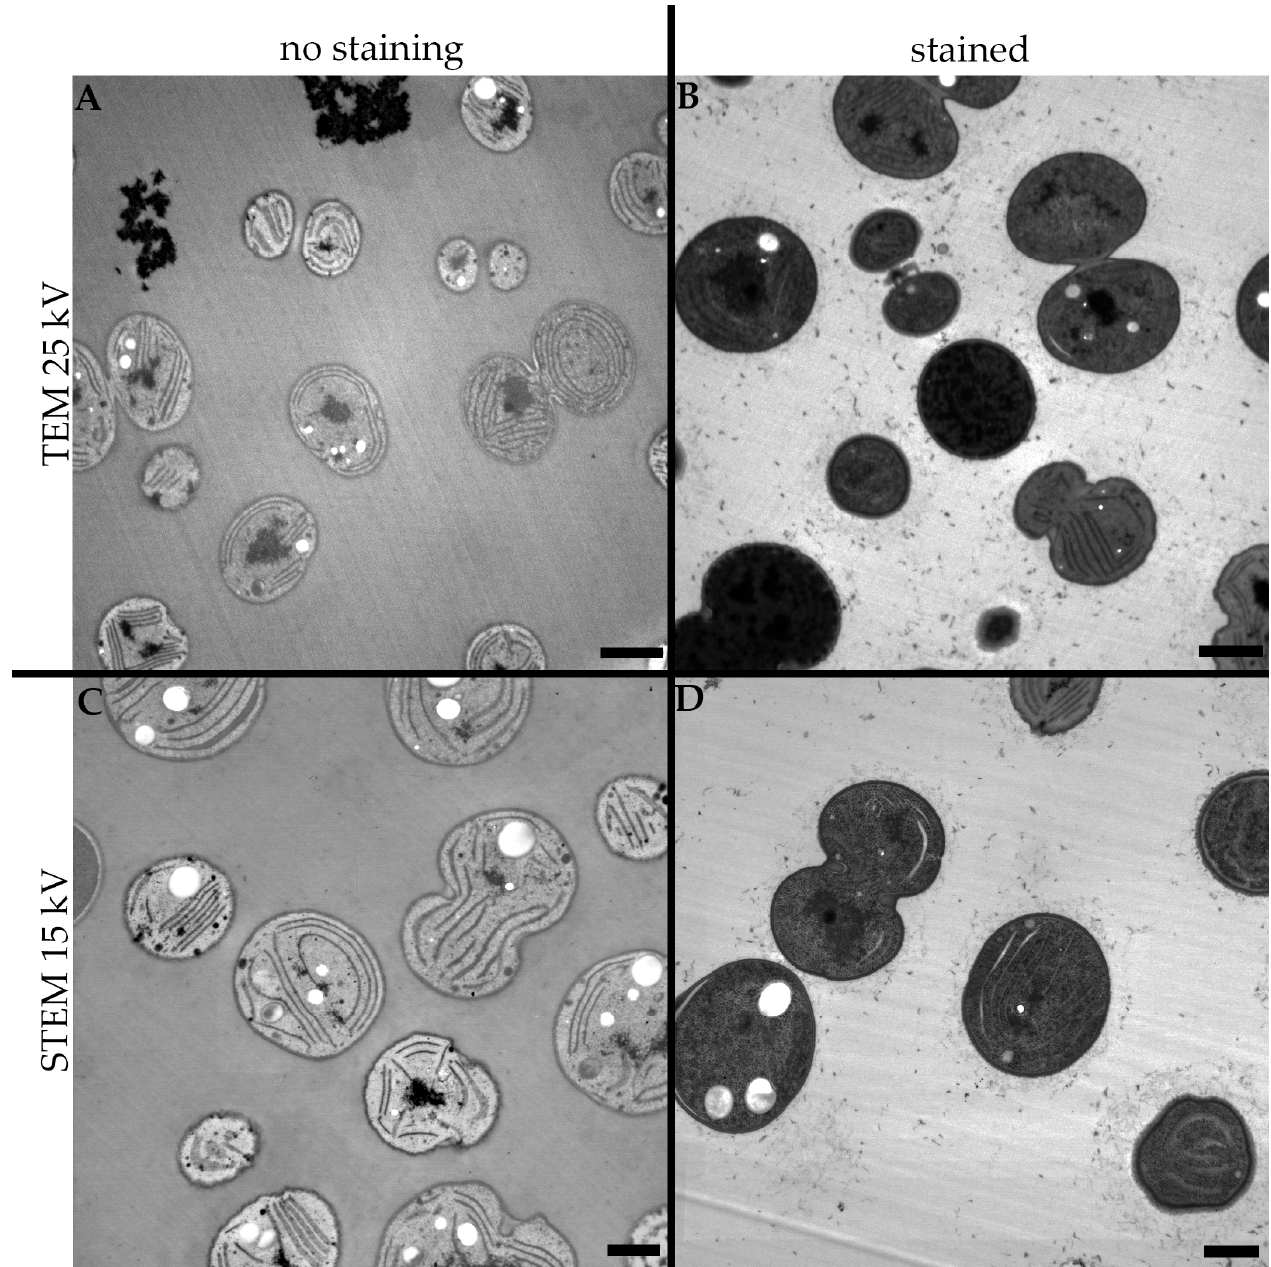
Figure 5. Comparison of the images of cyanobacterial cells obtained using a low voltage transmission electron microscope in different imaging modes. ( A ) Unstained sample imaged in TEM mode using a 25 kV accelerating voltage electron beam, ( B ) sample stained using uranyl acetate and lead citrate imaged in TEM mode using a 25 kV accelerating voltage electron beam, ( C ) unstained sample imaged in STEM mode using a 15 kV accelerating voltage electron beam, ( D ) sample stained using uranyl acetate and lead citrate imaged in TEM mode using a 15 kV accelerating voltage electron beam. Scale bar: 1 µm.